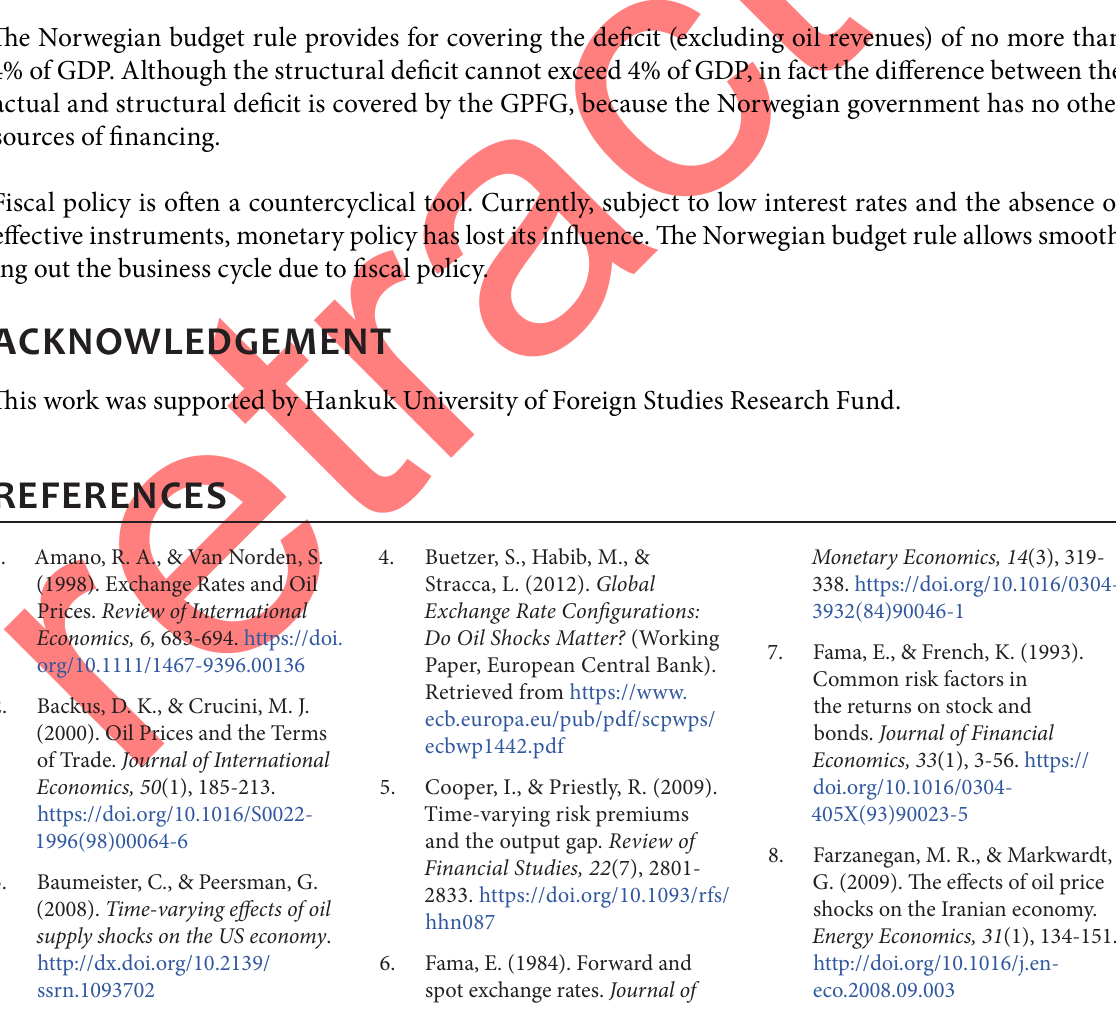
Figure 5. Assets of the Reserve Fund of the Russian Federation (solid line, left scale – billion USD, solid line, right scale – % of